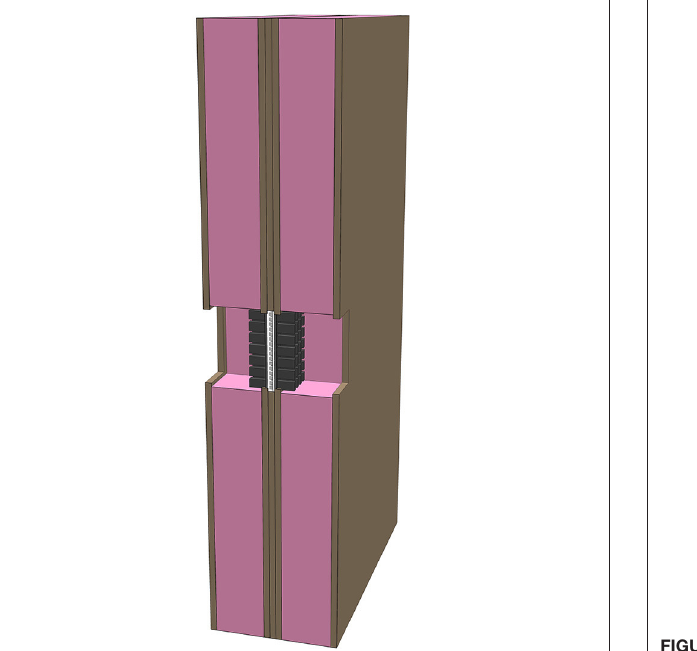
FIGURE 4 | Architectural proof of concept model section for thermoelectric facade (direct contact assembly).